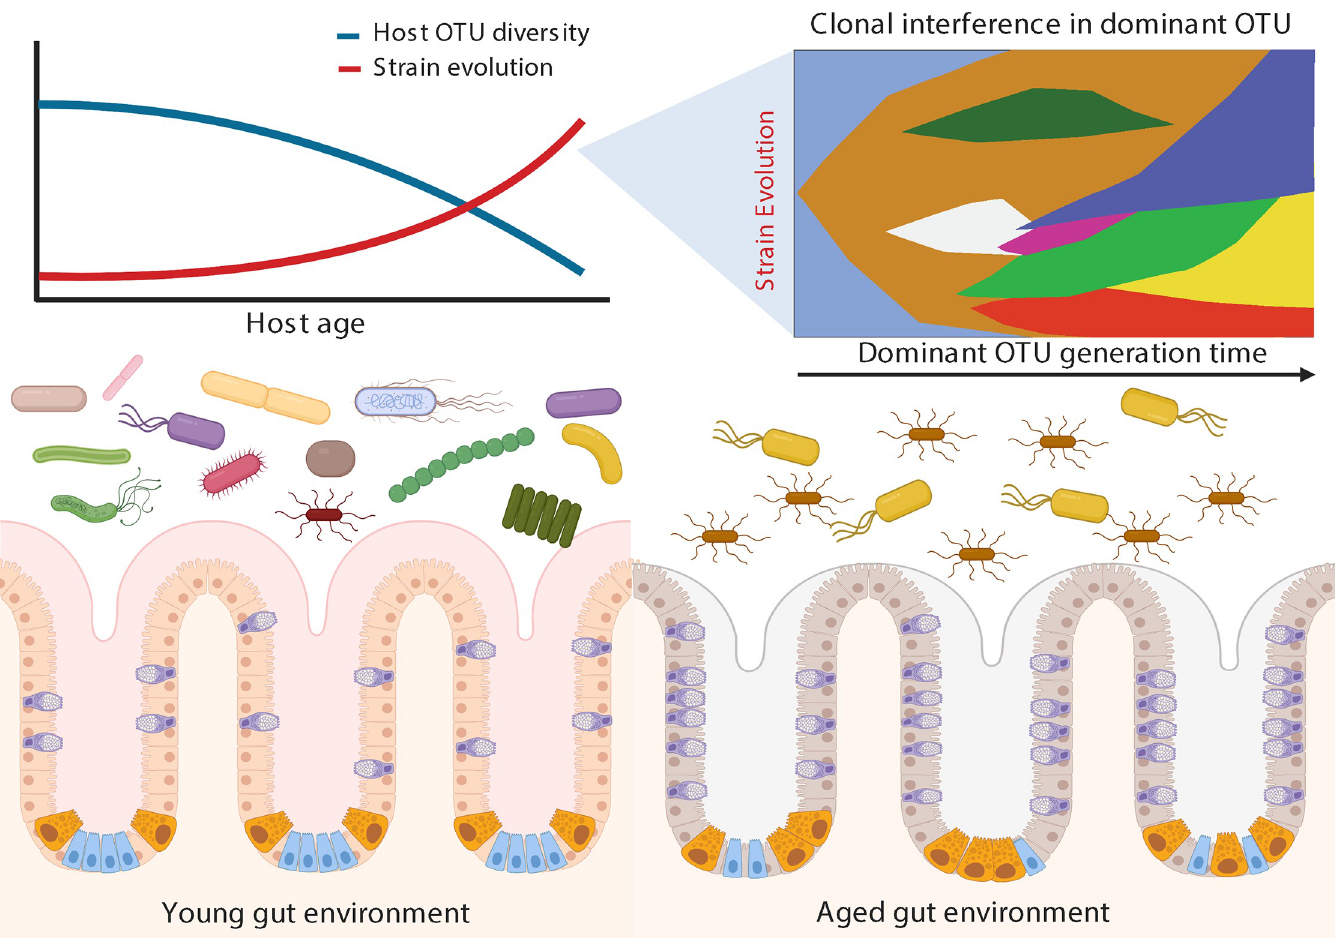
Fig 1. The gut microbiota undergoes dynamic changes during host aging. Changes in host intestinal cell composition and architecture occurring during aging are matched by a decrease in the microbiota taxonomic diversity. Age-related decrease in taxonomic diversity in the commensal community leads to larger population size for a few age-associated microbial species, increasing the chances for the evolution of novel potentially pathogenic microbial strains. OTU, Operational Taxonomic Unit. This figure was generated wtih Biorender.